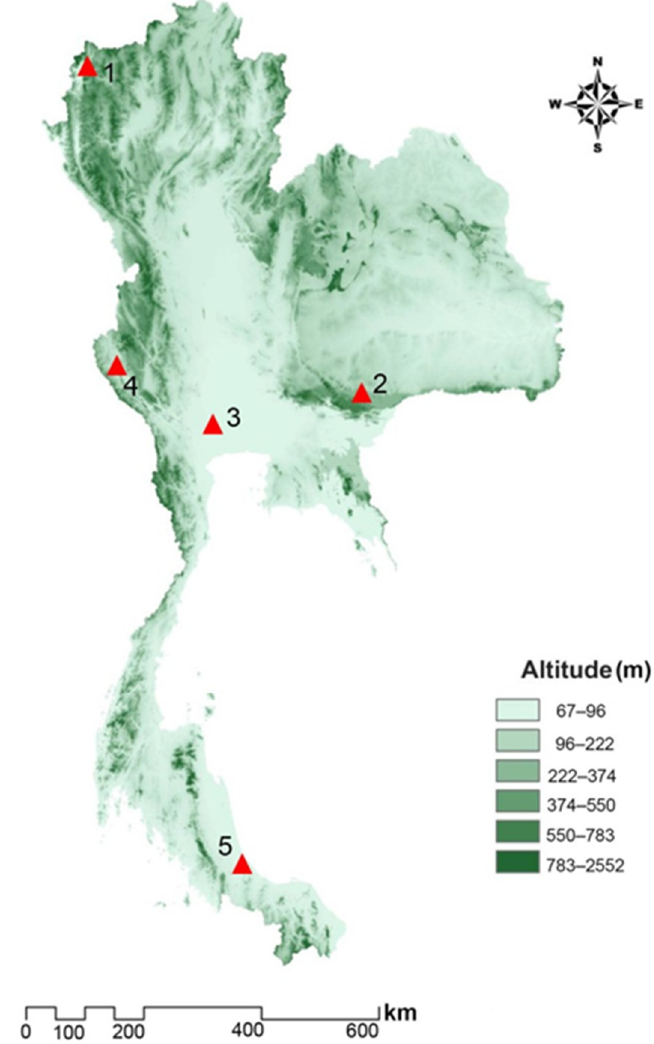
Figure 1. Map of S. calcitrans populations in Thailand: Mae Hong Son (1), Nakhon Ratchasima (2), Nakhon Pathom (3), Kanchanaburi (4), and Songkhla (5).